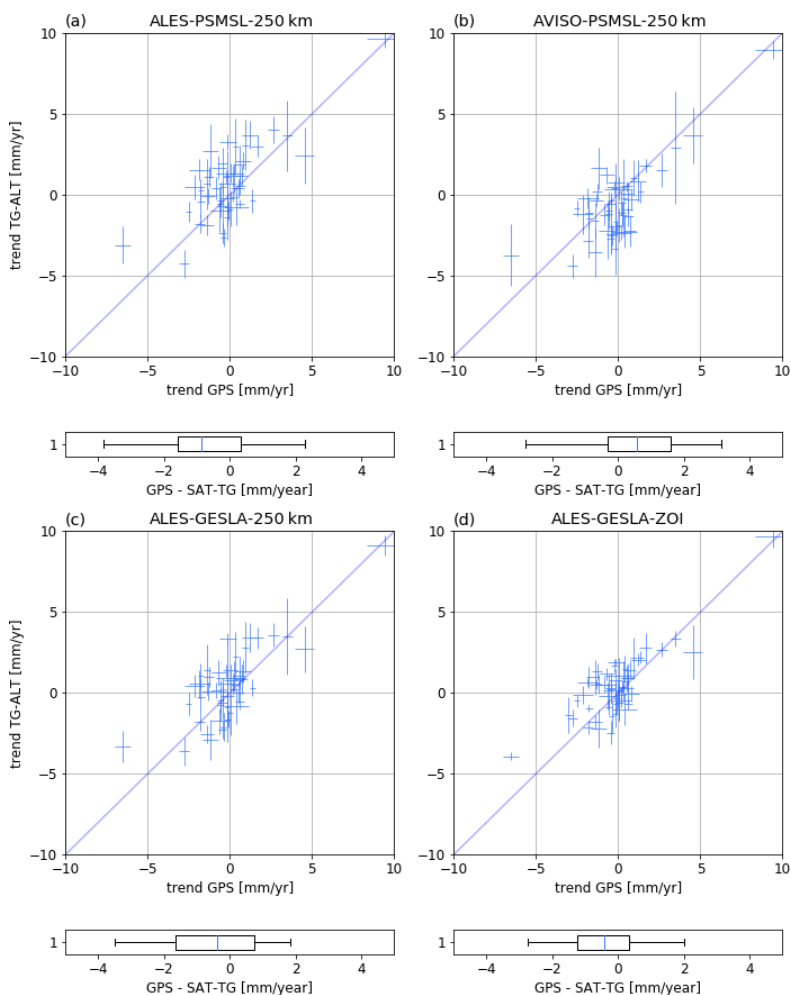
Figure 4. Scatter and box plots comparing estimated SAT–TG trends and GNSS trends, as in WM16 Fig. 14. (a) ALES–PSMSL-250km, (b) AVISO–PSMSL-250km, (c) ALES–GESLA-250km and (d) ALES–GESLA–ZOI (at 20% threshold based on the rms criterion). Error bars denote the 1 σ trend uncertainties of the individual